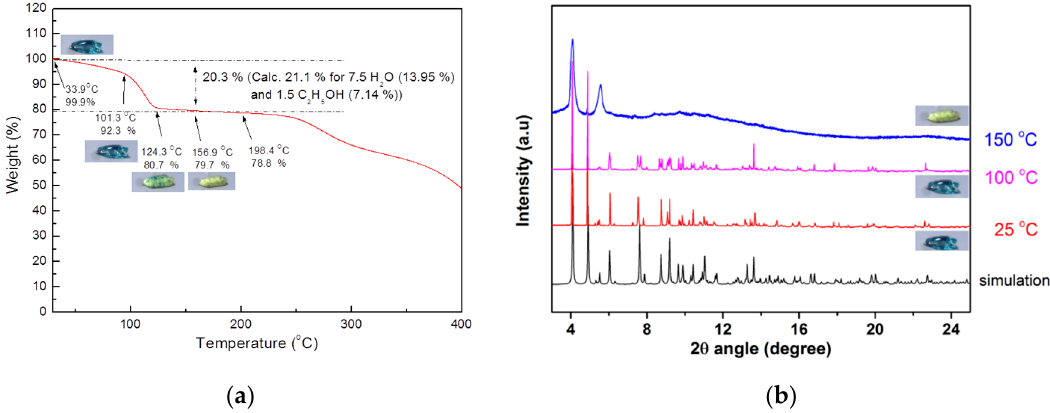
Figure 2. ( a ) Thermogravimetric (TG) measurement associated with morphological changes at selected temperatures of 1 . ( b ) Powder X-ray diffraction patterns of 1 at RT and selected temperatures and its simulation from single-crystal diffraction data associated with morphological changes at selected temperatures of 1 . The baselines for each temperature were shifted for clarity.